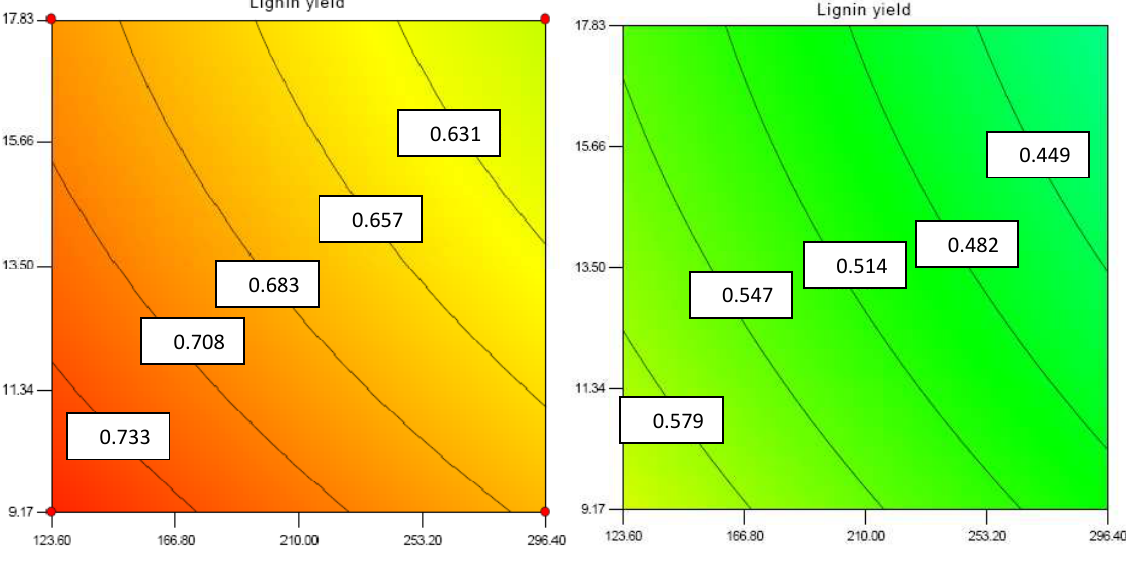
Fig. 2-A. X: time (min), Y: Pressure (bar), temperature 113 0 C